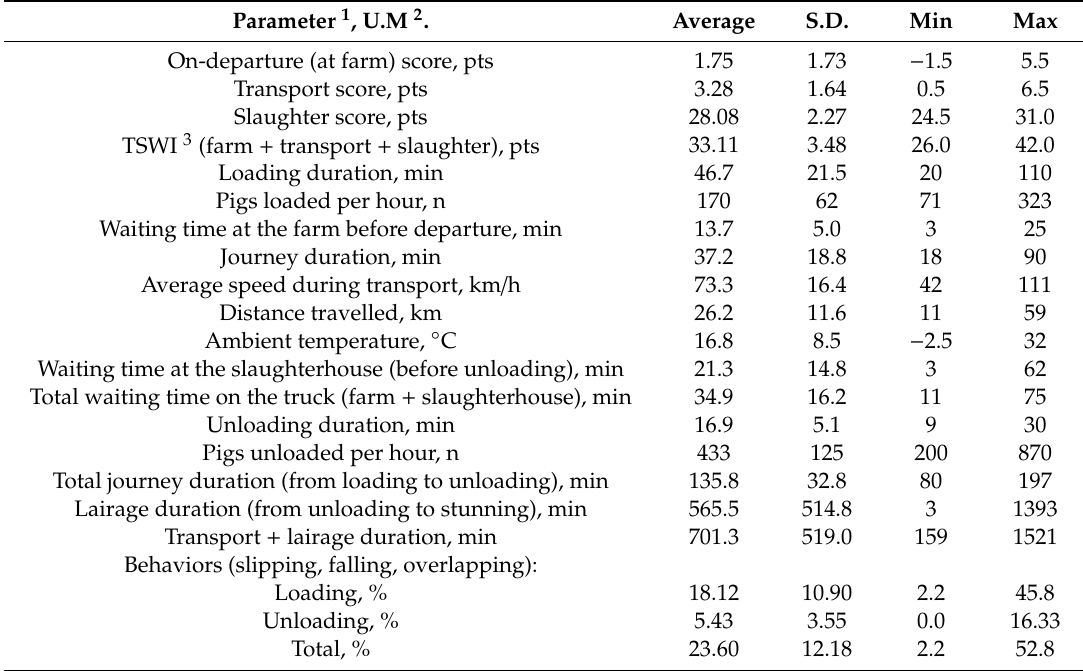
Table 1. Descriptive statistics of the pig shipments (N =